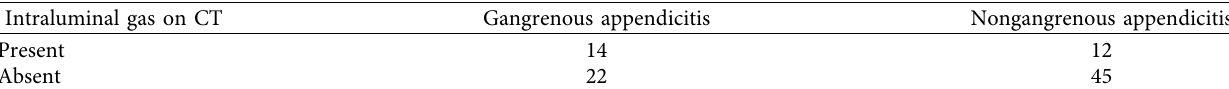
Table 1: Cases of appendicitis with or without CT-detected intraluminal gas, correlated with the final histopathological report of absence or presence of gangrenous appendicitis.